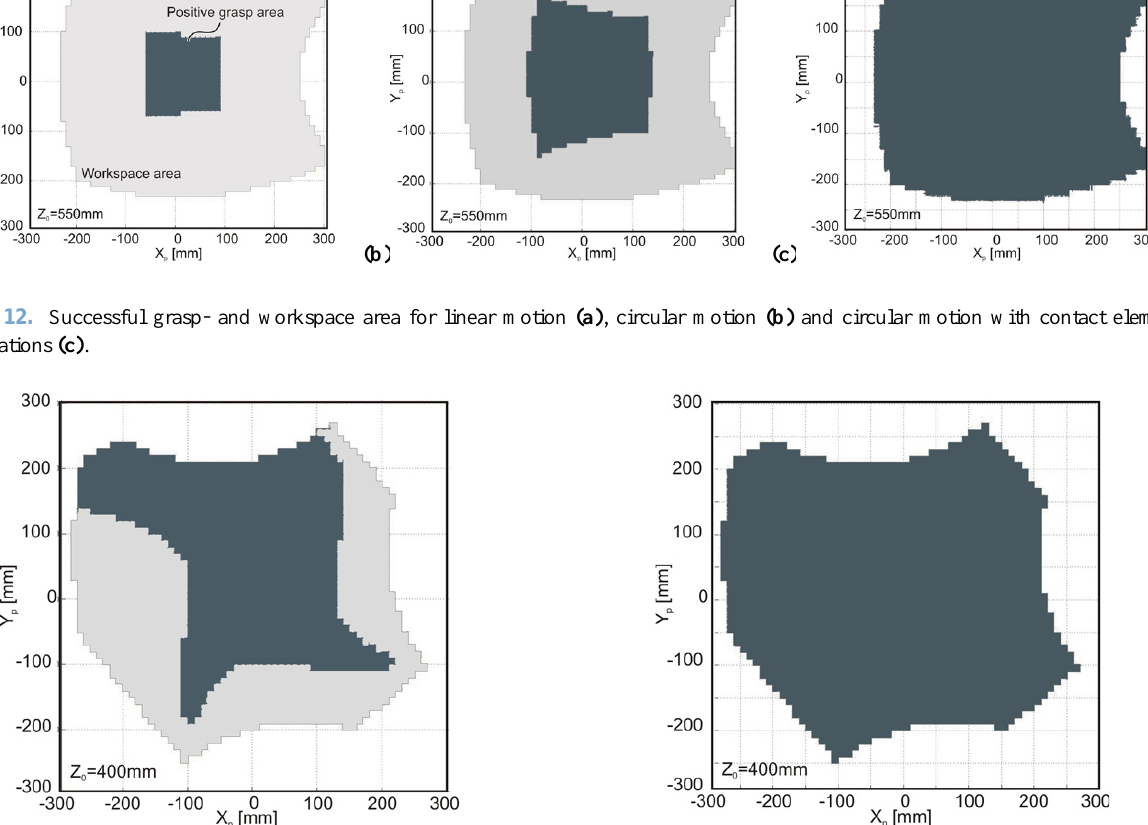
Figure 14. Enhanced grasping with object orientation φ = 45 ◦ and wrist joint configuration